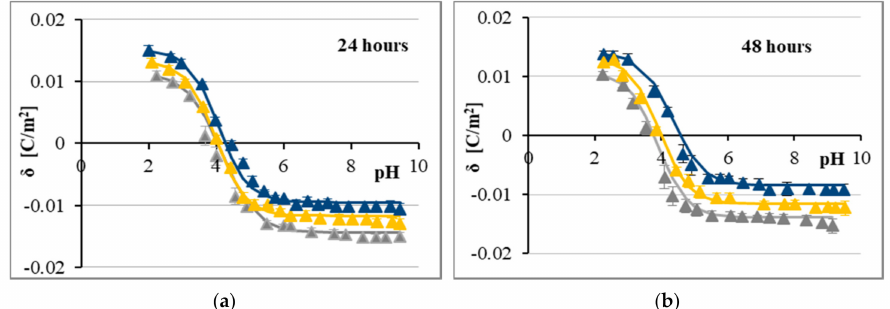
Figure 3. Surface charge density of LN-229 cell membrane versus pH of electrolyte solution. The cells were untreated (grey) or treated with 1.0 (yellow) and 5.0 (navy blue) mmol / dm 3 of FA for 24 h ( a ) and 48 h ( b ). Points denote the experimental values, and the continuous line links the theoretical